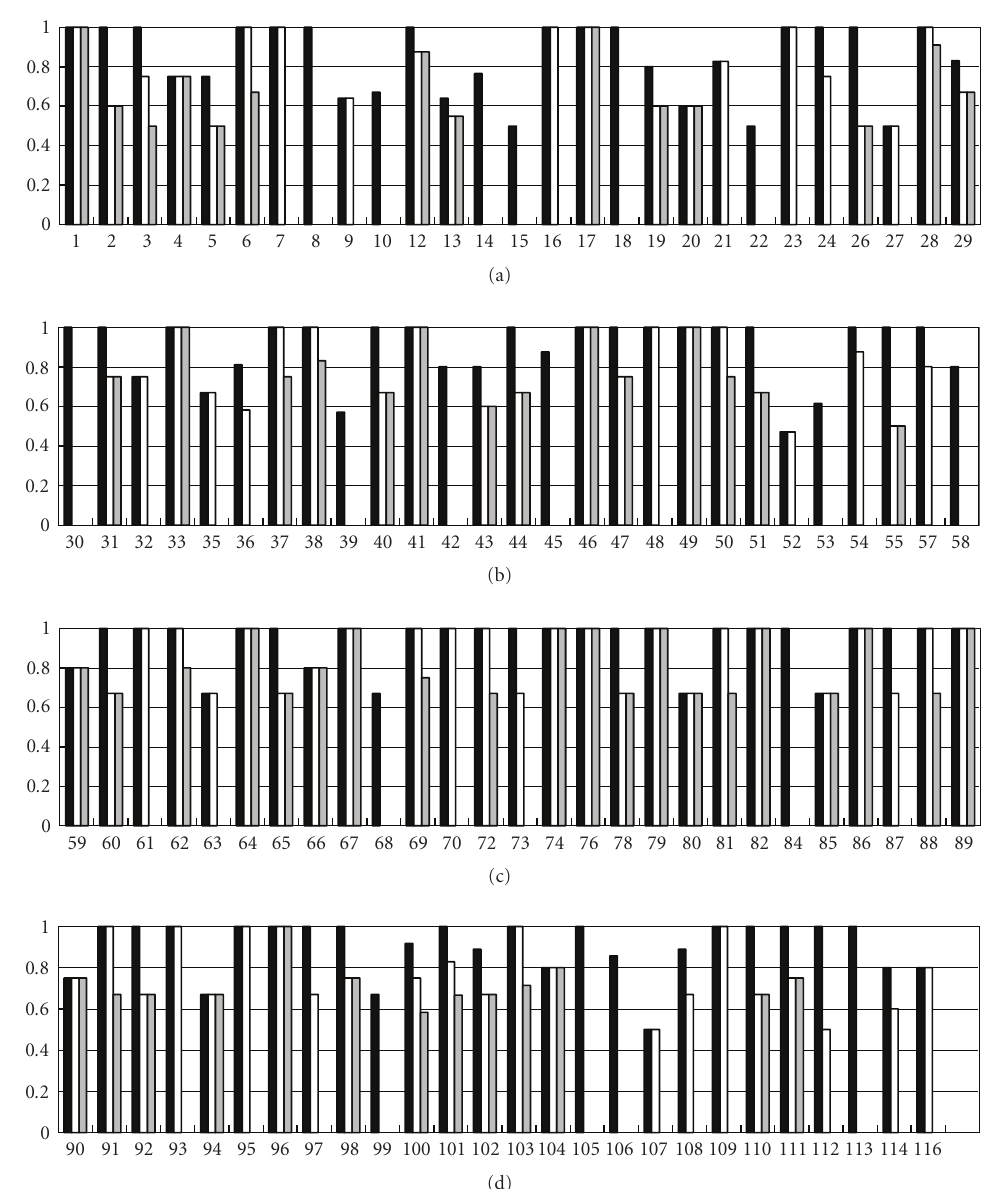
Figure 4: The functional coherence in each of the 116 groups, computed as the ratio of the number of proteins having a specific functional category to the number of proteins in the group. The black, white, and grey bars represent functional categories with the ratios ≥ 0 . 5 and the maximum number of such ratios is limited to 3 in each group.